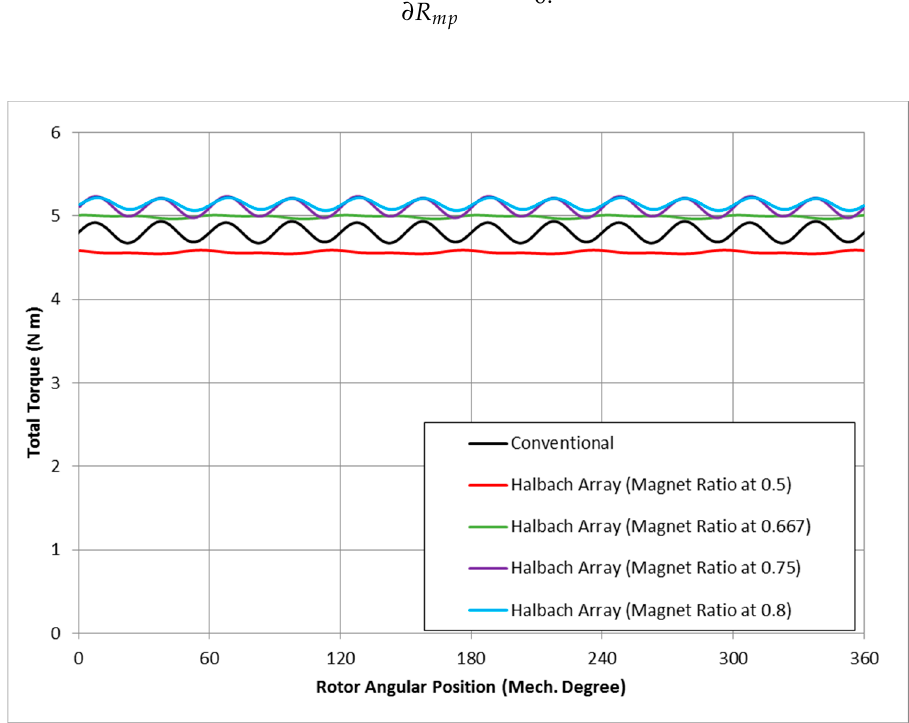
Figure 15. Comparison of Analytically Predicted Torque with Different Magnet Ratio Values.